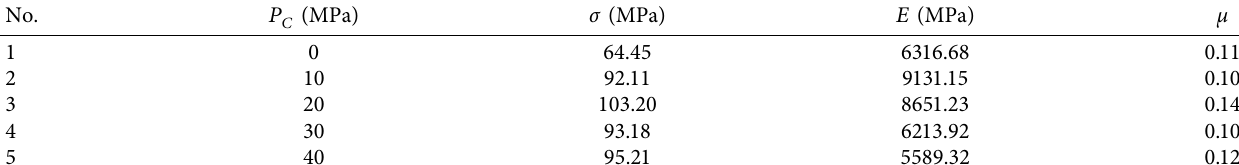
Table 3: Results of triaxial compression